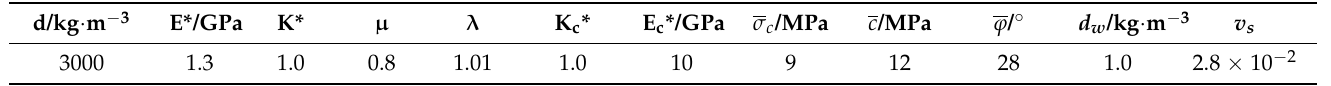
Figure 5. PFC 3D model and monitoring scheme. Table 1. Particle gradation table. Table 2. Particle Flow Model Meso-parameters.